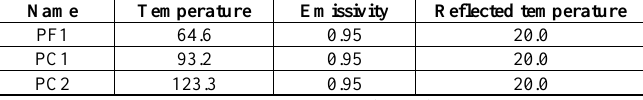
Figure 3: Burns on solar module caused by severe hot spots. Table 2: Markers referring to the analysis of Figure 3.